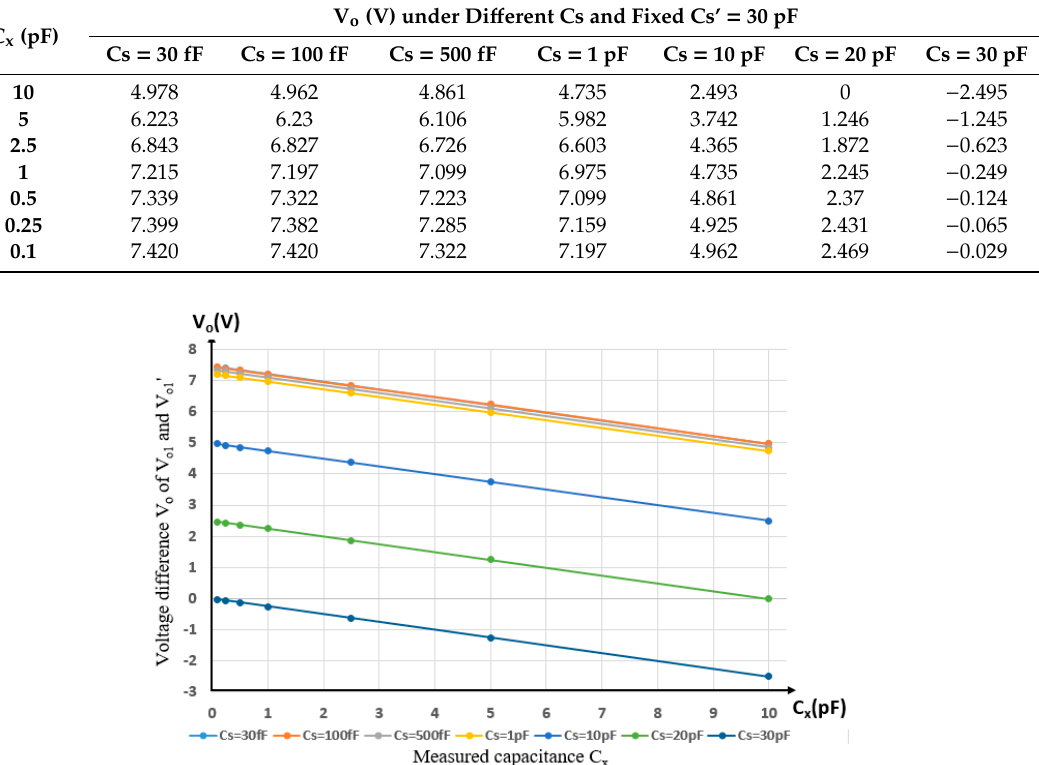
Table 4. The output voltage V o under di ff erent C x and C s .